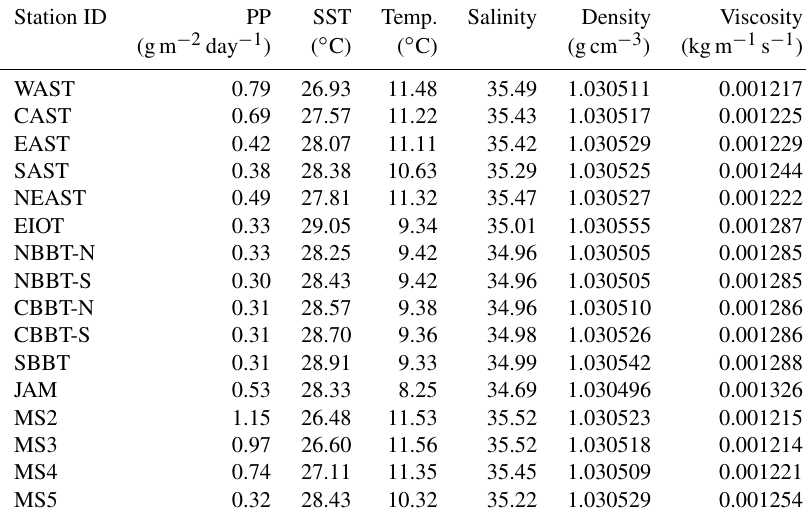
Table 5. Trap ID, annual mean primary production (PP) and sea surface temperature (SST) as well as seawater temperature (Temp.) and salinity. Temperature and salinity were selected for trap sites from the World Ocean Atlas 2013 and averaged between a water depth of 100 and 1500m. Density and viscosity were calculated by using temperature and salinity, considering a water depth of 800m. Python routines GSW and IAPWS were used for these calculations. In addition to our trap site, data for the US JGOFS trap sites MS2–5 were also selected. Figure 1 shows the location of these sites.